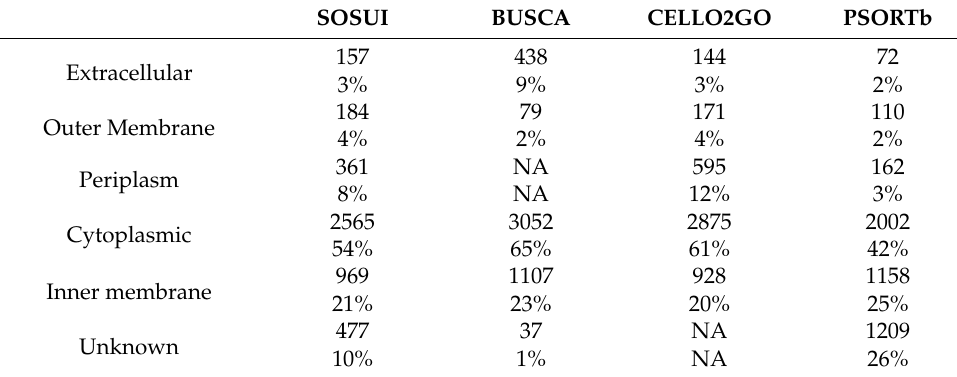
Table 2. Quantity and proportion of predicted subcellular localization of S. Pullorum R51 proteins according to SOSUI, BUSCA, CELLO2GO, and PSORTb servers. SOSUI BUSCA